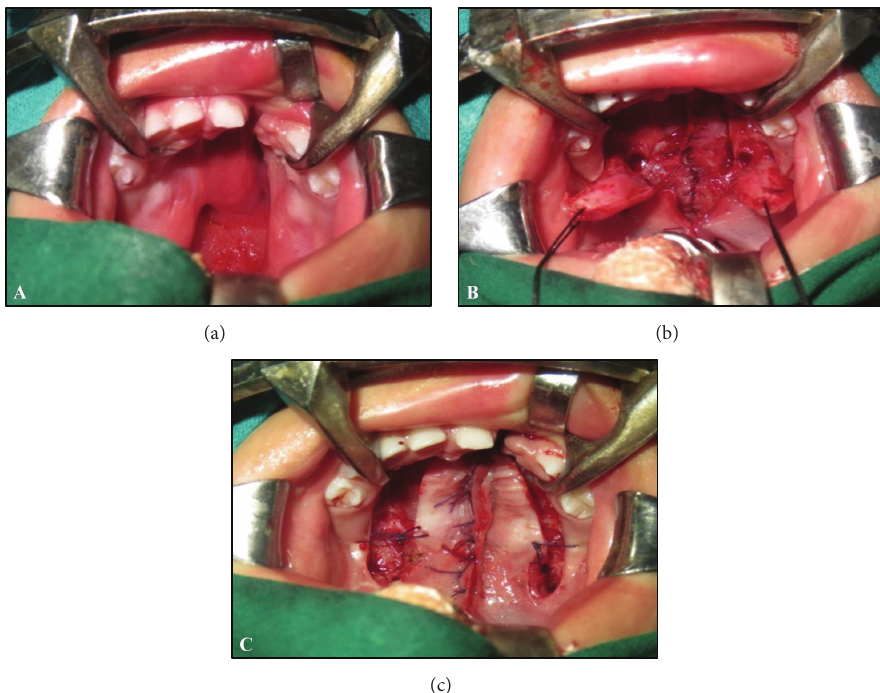
Figure 1: Bardach’s two-flap palatoplasty. (a) Preoperative photograph showing complete cleft palate of left side. (b) Photograph showing elevated flaps bilaterally based on greater palatine arteries. (c) Photograph showing closure of cleft